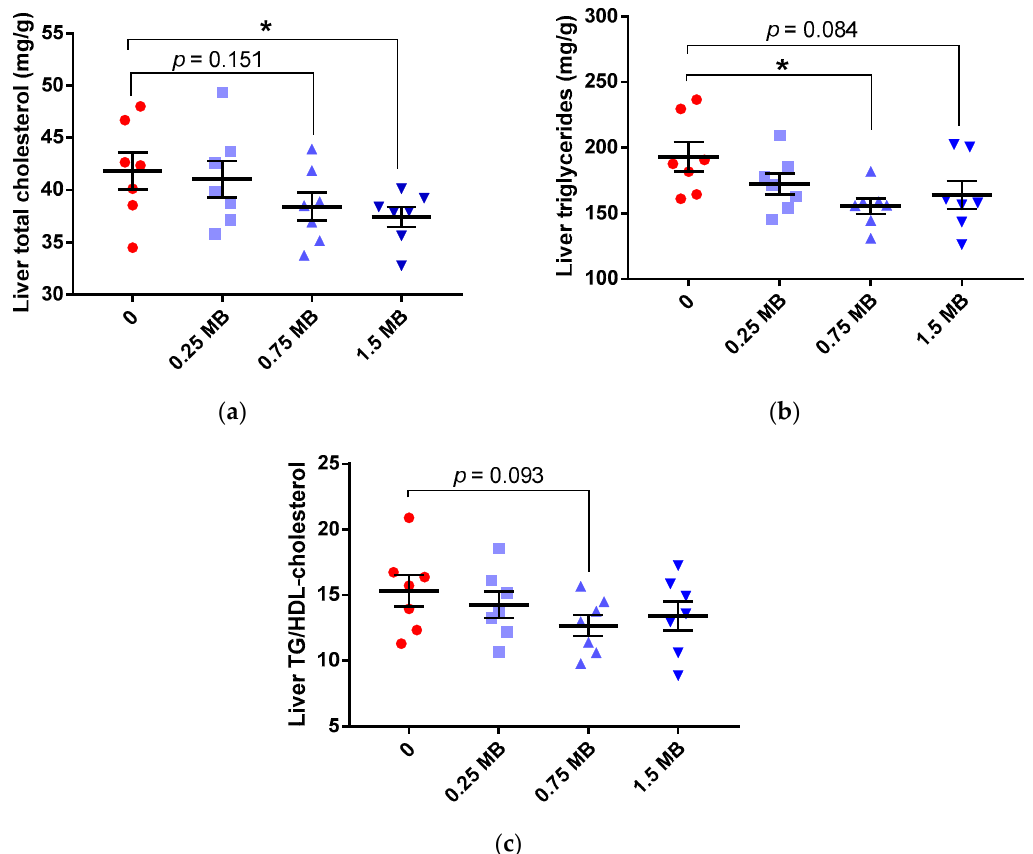
Figure 1. Liver lipids in rats fed a high-fat control diet with butter (0), or the same diet supplemented with 0.25 MB g/100 g (dry weight basis) (0.25 MB), 0.75 MB g/100 g (0.75 MB), or 1.5 MB g/100 g (1.5 MB) for 3 weeks. ( a ) Total cholesterol (mg/g, p < 0.05, unpaired, 2-tail t -test), ( b ) triglycerides (mg/g, p ANOVA = 0.0447, one-way ANOVA and post-hoc Dunnett’s test), ( c ) TG/HDL-cholesterol ratio ( p = 0.093, unpaired, 2-tail t -test). Values are means ± SEM. Mean values were significantly different from the control group: * p < 0.05. MB, monobutyrin; HDL-cholesterol, high-density lipoprotein-cholesterol; TG, triglycerides.